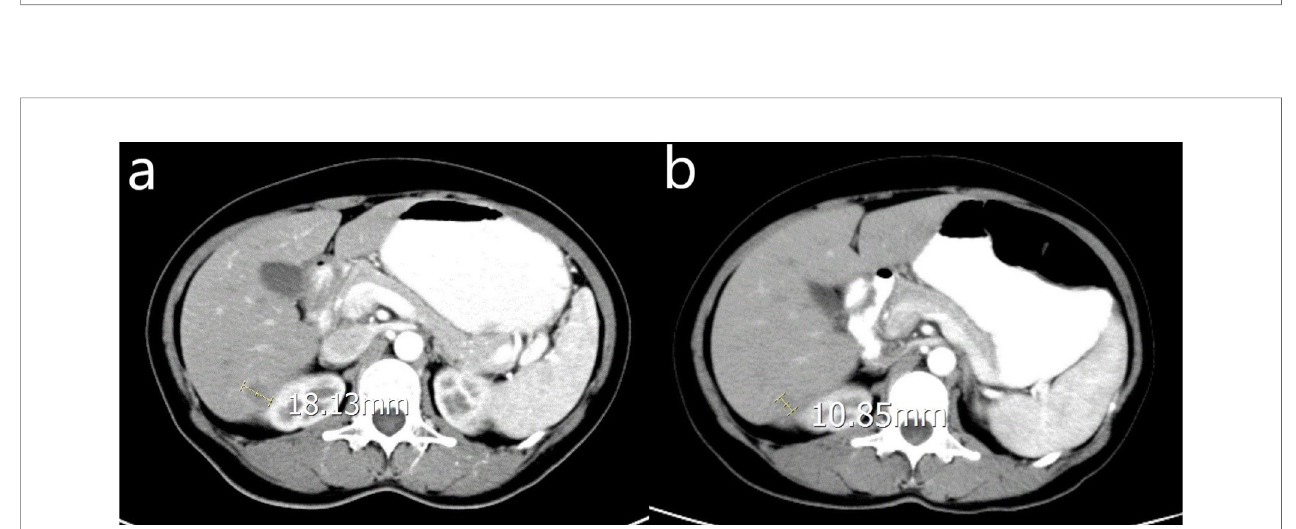
FIGURE 2 | CT image of a woman with OCLM underwent chemotherapy only. (A) the location and diameter of the tumor before chemotherapy; (B) the location and diameter of the tumor one month after